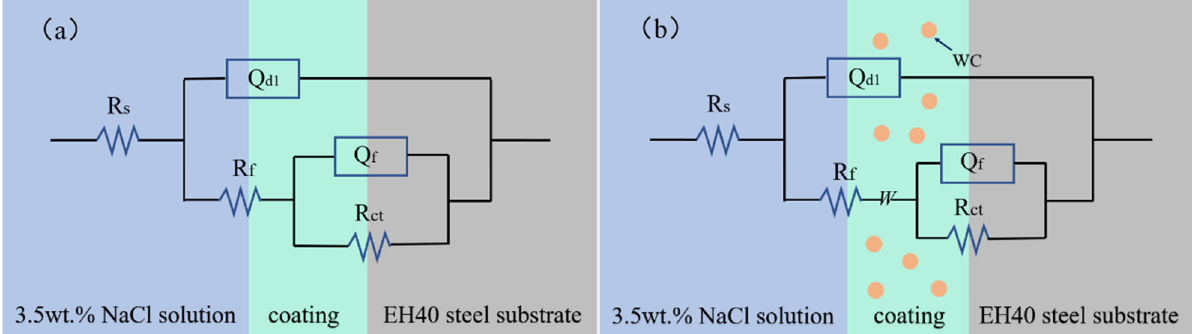
Figure 10: Equivalent circuit used for fi tting impedance in 3.5 wt% NaCl solution: ( a ) Co coating; ( b ) WC – Co